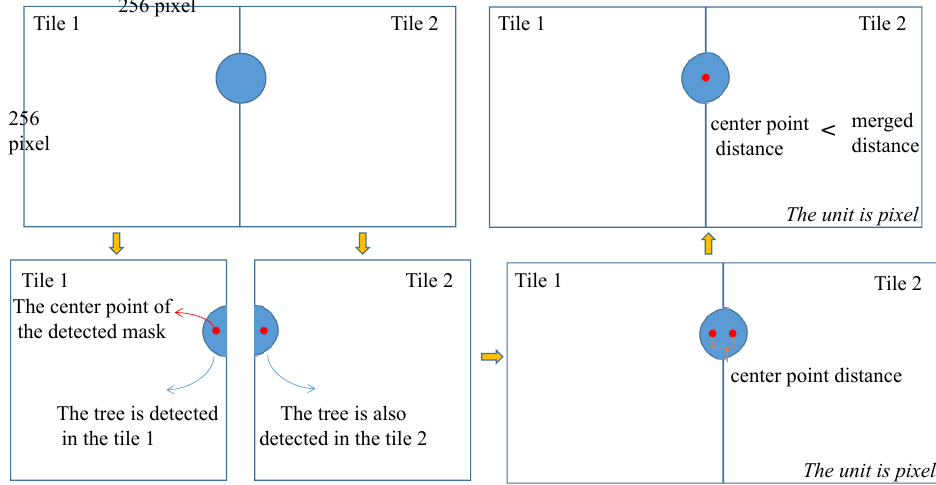
Figure 8. The description of the merged distance. If the center point distance between two adjacent tree masks is less than the preset merged distance, two points or more points in the boundaries from neighbouring tiles would be fused into one